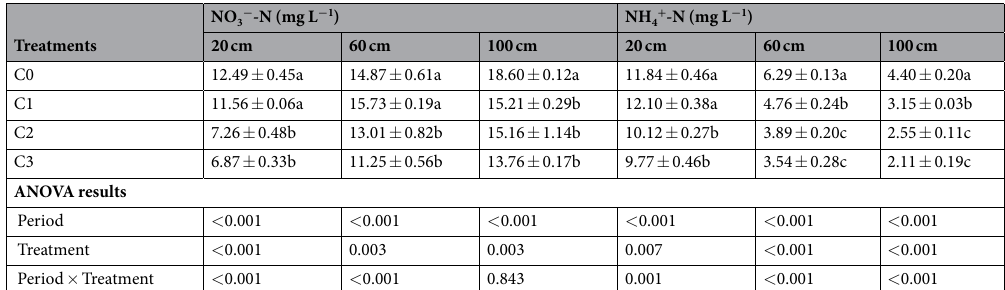
Table 2. Soil NO 3 − -N and NH 4 + -N leaching at various soil depths affected by different treatments over the entire experimental period. Data are mean ± SE. Lowercase letter in the same column represents significant differences among experimental treatments at the level of